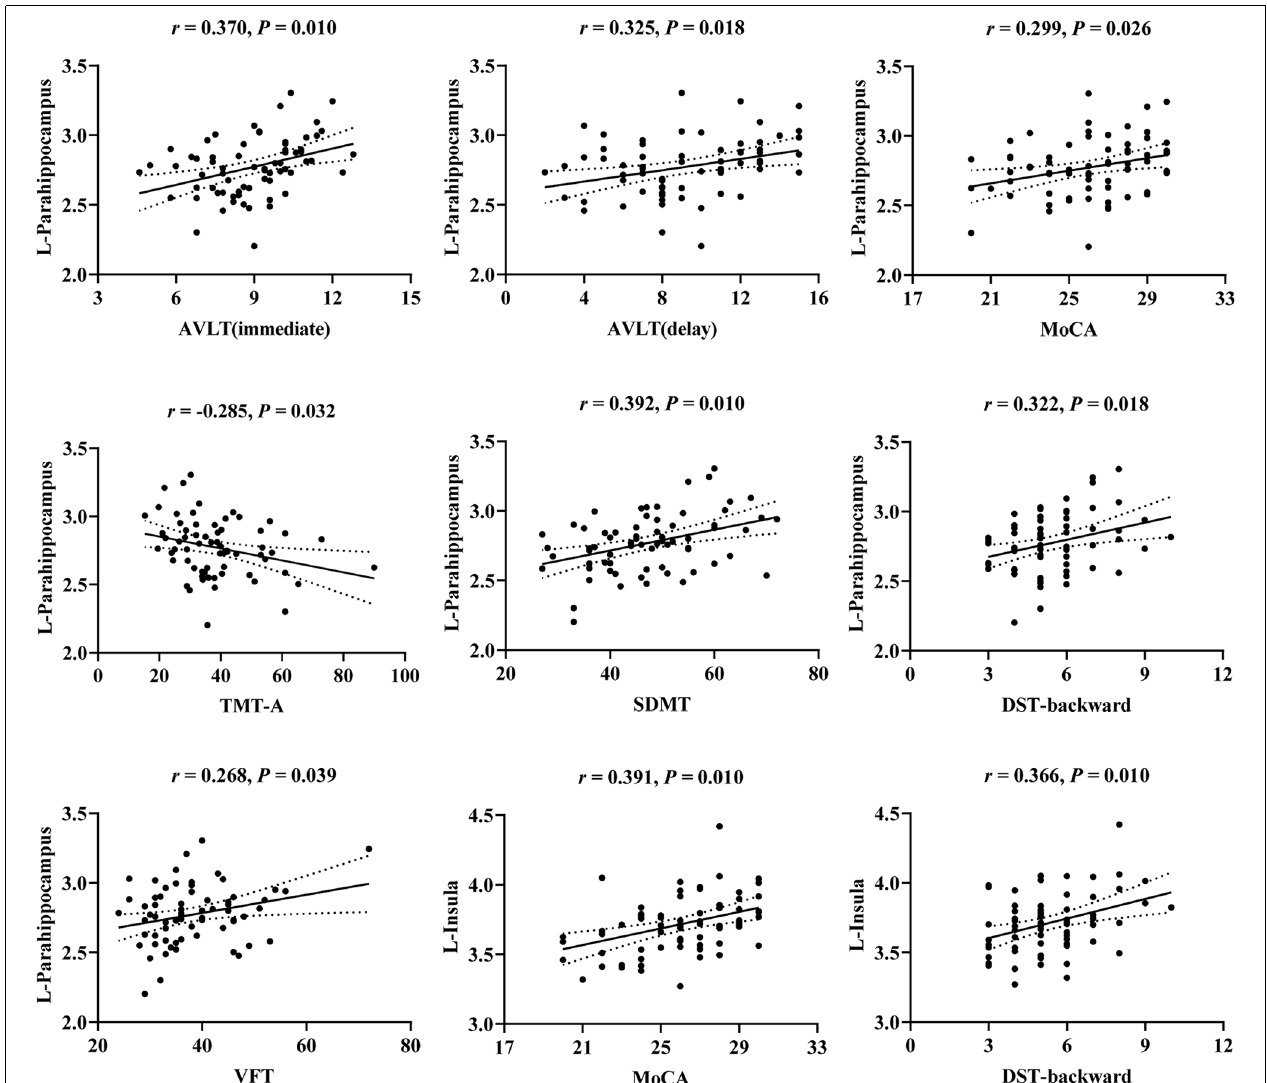
FIGURE 2 | Scatter plots of the correlations between cognitive scores and cortical thickness of the left parahippocampus and left insula in T2DM. r , correlation coefficient (Pearson’s correlations); P , the P -value after false discovery rate (FDR) correction; P < 0.05 was considered significant. L, left; AVLT, Auditory Verbal Learning Test; MoCA, Montreal Cognitive Assessment; TMT, Trail Making Test; SDMT, Symbol Digit Modalities Test; DST, Digit Span Test; VFT, Verbal Fluency